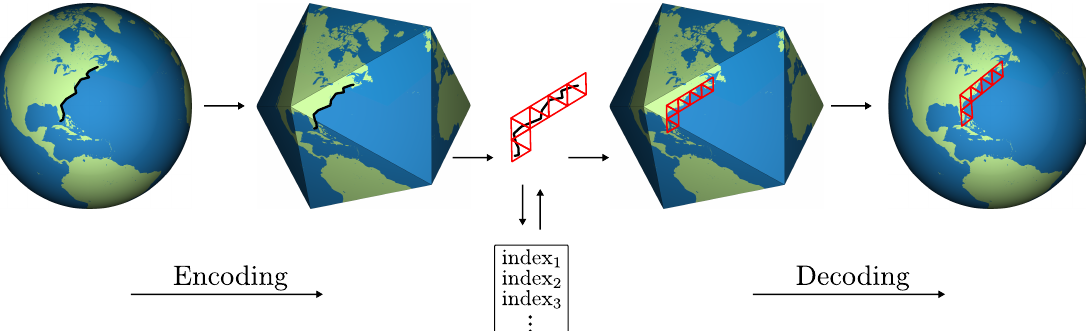
Figure 2. The process of encoding (left) and decoding (right) with a DGGS. Encoding: features are projected from the Earth domain to the polyhedral domain of the grid; the set of planar cells associated with the feature are obtained—each of which has a unique index. Decoding: a set of cell indices corresponds to cell geometry on the polyhedral grid; cells in the polyhedral domain are inverse projected back to the Earth domain. The process for a 3D DGGS is similar, except features and cells have associated